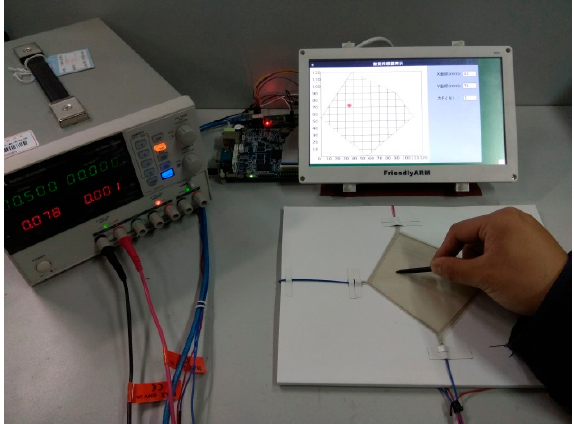
Figure 18. Position detection on the plane. Sensors 2019 , 19 FOR PEER REVIEW